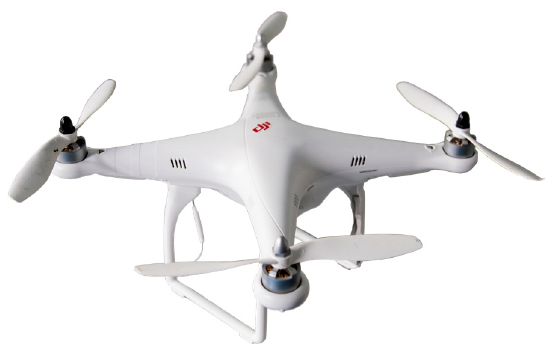
Figure 2. The DJI phantom UAV platform.